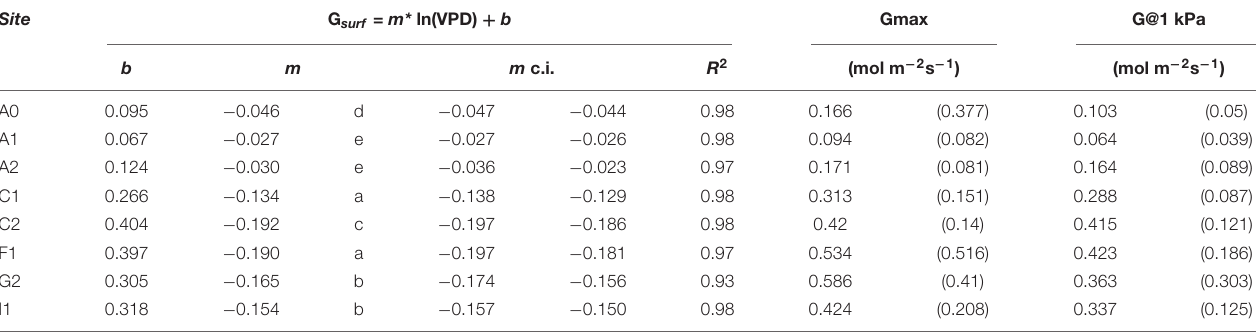
TABLE 3 | Output of the linear model computed as lm = [Grel ∼ log(VPD) + log (VPD) × site, where b and m are the parameter of the equation G rel = m × ln (VPD) + b . Site